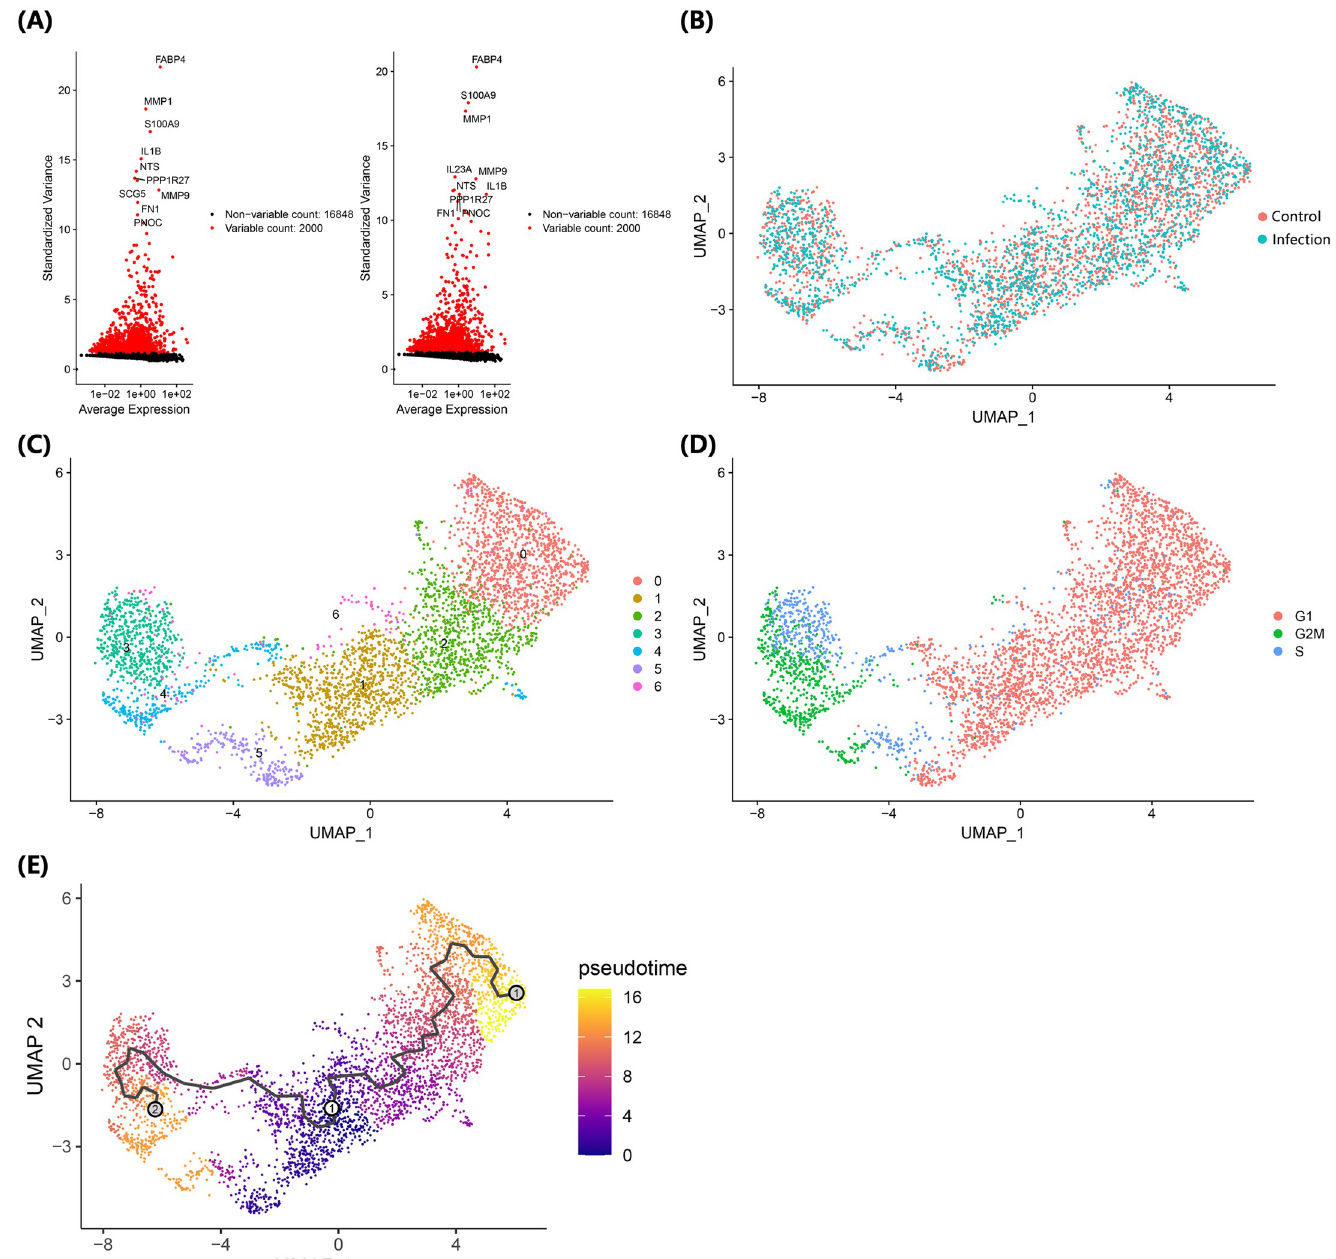
Fig 1. Single-cell transcriptional profiling of MAP-infected and control THP-1 cells after PMA treatment. Genes that showed variable features throughout the cell population and the top 10 features of the control group (left) and infection group (right) are described (A). Using the Seurat package, the UMAP plot of single cells was described with discrimination of the control and infection groups (B), formation of clusters (C), and cell cycle (D). Using the Monocle 3 package, the pseudotime of single cells was predicted with a trajectory analysis (E).